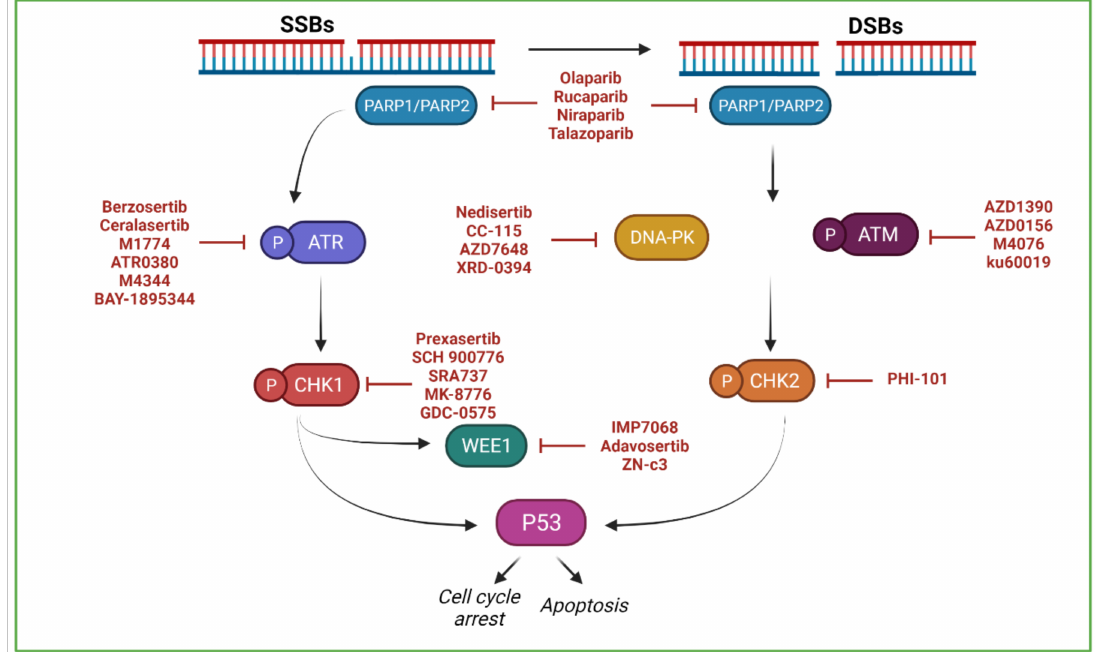
Figure 1. DDR-targeted agents that have been clinically approved or are in clinical trials. PARP-1 and PARP-2 become enzymatically active upon recognition of DNA breaks, cleave β -NAD + and transfer ADP-ribose moieties (PARylation) onto specific amino acid residues of acceptor proteins. The kinases ATR and ATM phosphorylate hundreds of proteins, including CHK1 and CHK2, respectively, which are key mediators of the checkpoint function. Whereas ATM is activated by DNA double-strand breaks (DSBs), ATR is activated by DNA single-strand breaks (SSBs). The kinase DNA-PK is critical for DSB repair via the non-homologous end-joining pathway. The kinase WEE1 controls mitotic